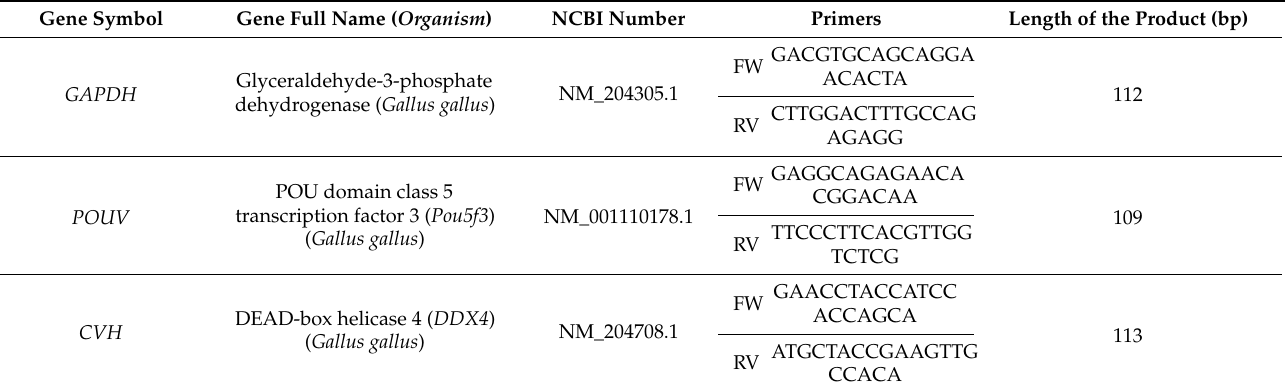
Table 1. Primers used at the mRNA analysis.